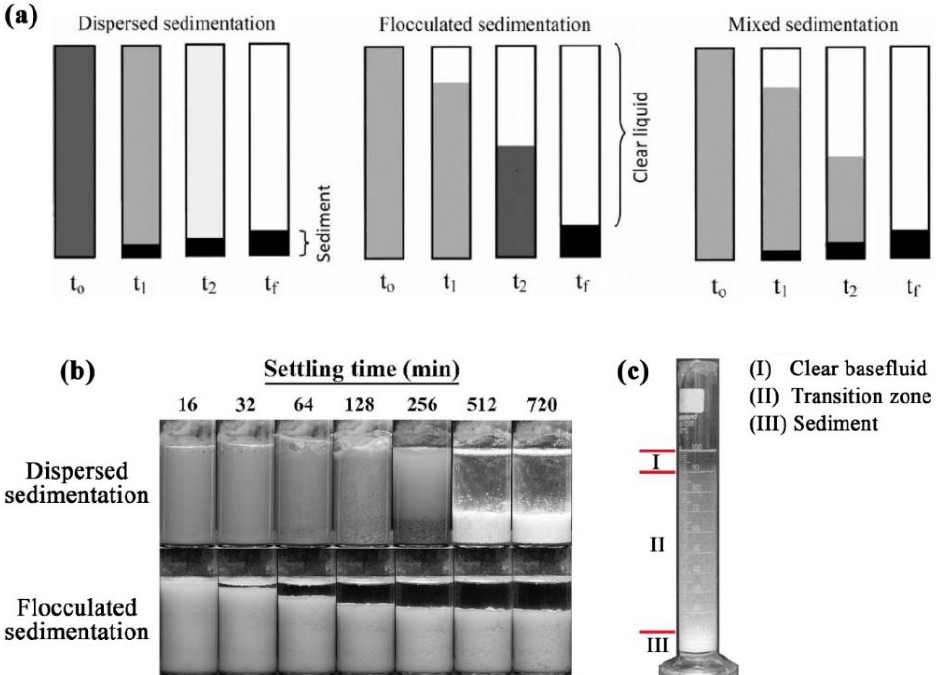
Figure 12. The three types of sedimentation behaviours, where ( a ) shows their schematic mechanism from the starting time (t o ) to the finishing time (t f ) [8], ( b ) demonstrates the dispersed and flocculated sedimentation behaviors from Ali et al. [8] experimental work, and ( c ) represents the mixed sedimentation behavior shown in Ma and Alain [174] investigation.